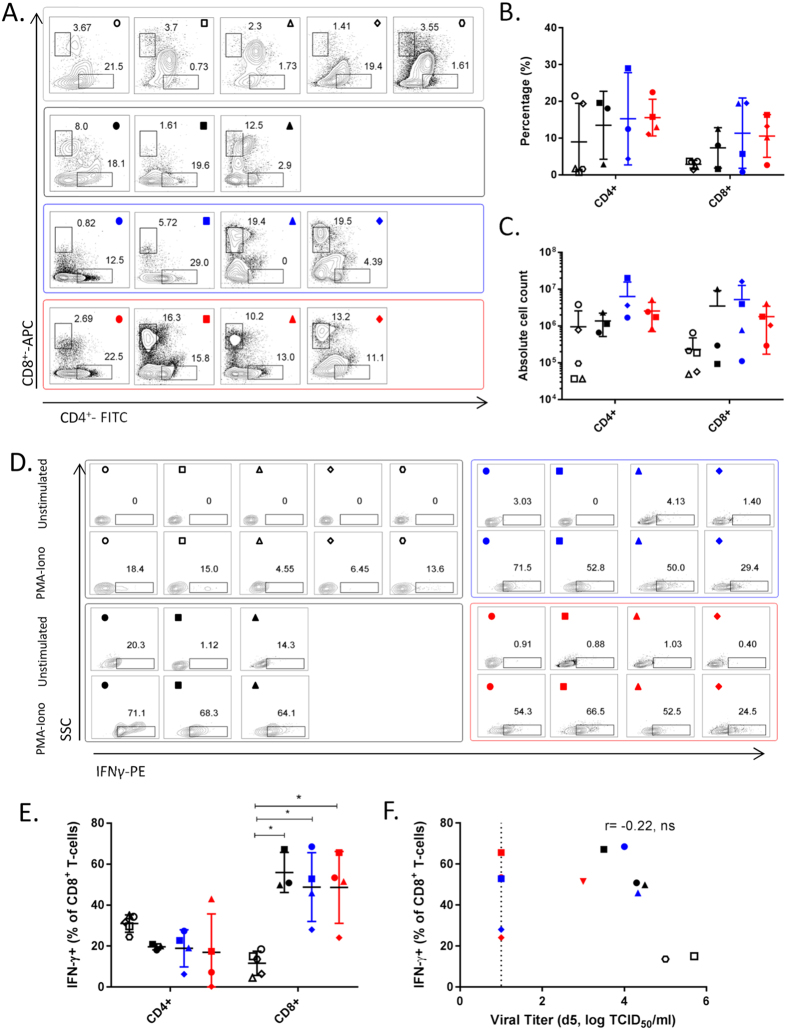
T-cell responses in the blood at time of euthanasia or on day 7 post-challenge with wild-type A/Viet Nam/1203/2004 (H5N1). (A) Flow plots to identify CD4+ and CD8+ T-cells in the blood for each ferret as indicated in Fig. 1. (B) Percentage and (C) absolute numbers of of CD4+ and CD8+ T-cells in the blood. (D) Flow plots showing the percentage of IFN-γ+ cells within the CD8+ population for unstimulated and PMA/Ionomycin stimulated cells for each ferret as indicated in Fig. 1. The percentage of unstimulated cells was subtracted from the PMA/Ionomycin stimulated cells for each individual ferret to obtain the values shown in (E). Negative values are set at 0. (E) Percentage of CD8+ IFN-γ+ T cells after ex vivo stimulation of PBMCs with the PMA/ionomycin mitogen cocktail. All data are presented as group means and error bars represent ±standard deviation. *p < 0.05, **p < 0.01 by Kruskal-Wallis test, followed by Dunn’s multiple comparison tests. (F) Correlation between the percentage of CD8+ IFN-γ+ T-cells with day 5 viral titers in the nasal wash. Correlation was determined using Pearson’s correlation coefficient, (r) with the p-value as indicated. Dashed line indicates limit of detection (LOD) of the virus titration assay. Individual ferrets are assigned its respective symbol within its vaccine group (colored as ○ for naïve, ● for unadjuvanted,  for MF59 and  for AS03).